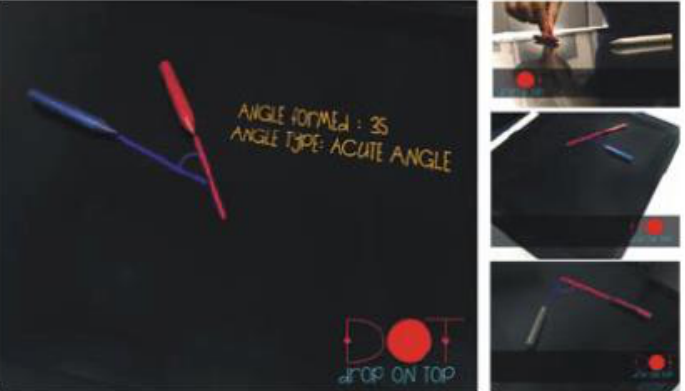
Figure 3. Formation of acute angle [16].